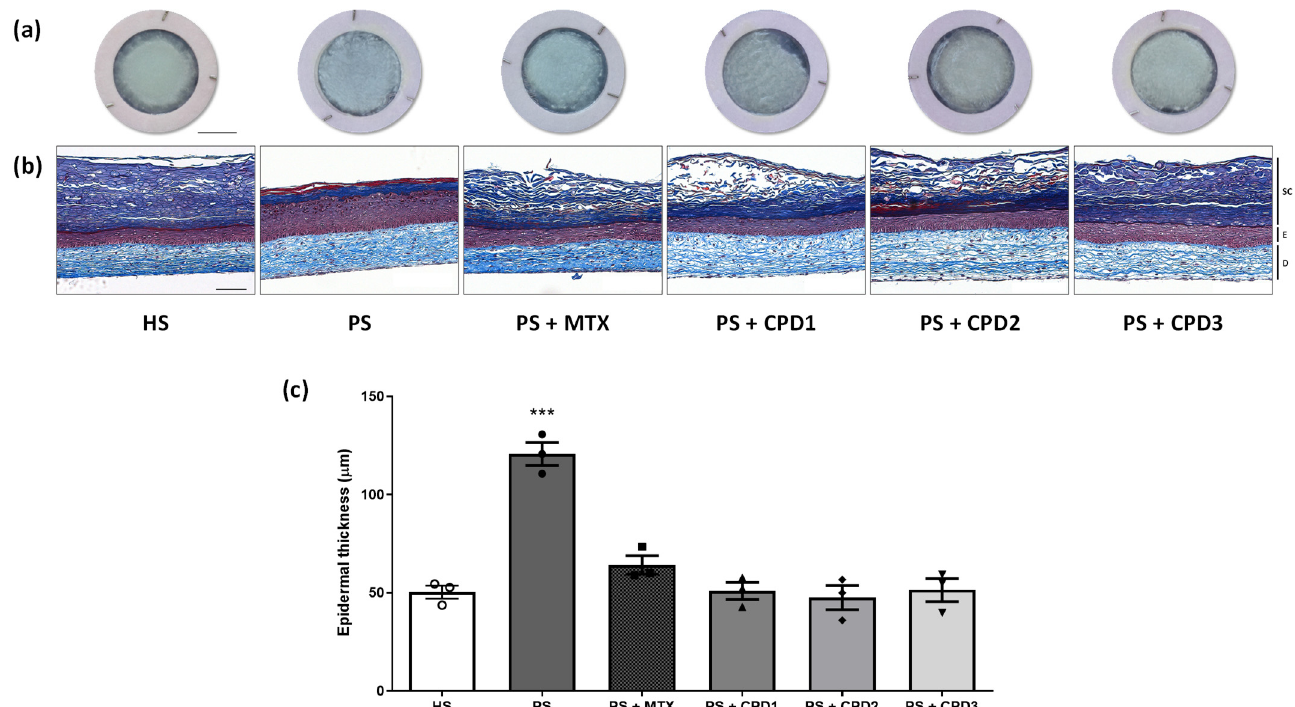
Figure 2. Effect of CPD1, CPD2 and CPD3 on skin morphology. ( a ) Macroscopic analyses and ( b ) histological cross-section with Masson’s trichrome staining of healthy substitutes (HSs); psoriatic substitutes (PSs); and psoriatic substitutes treated with methotrexate (MTX), quebecol (CPD1), ethyl 2,3,3-tris(3-hydroxy-4-methoxyphenyl)propenoate (CPD2) and bis(4-hydroxy-3-methoxyphenyl)methane (CPD3). Scale bars: ( a ) 1 cm; ( b ) 100 μ m. SC: stratum corneum, E: epidermis, D: dermis. ( c ) Living epidermis thickness measurements from the histological analyses of HS (white circles), PS (black circles), PS + MTX (black squares), PS + CPD1 (black triangles), PS + CPD2 (black diamonds) and PS + CPD3 (black inverted triangles). Data are presented as means ± SD of the three biological replicates; N = 3, n = 2, 60 measurements per biological replicate. Statistical significance was determined using a one-way ANOVA followed by a Tukey’s post hoc test, *** p < 0.001.